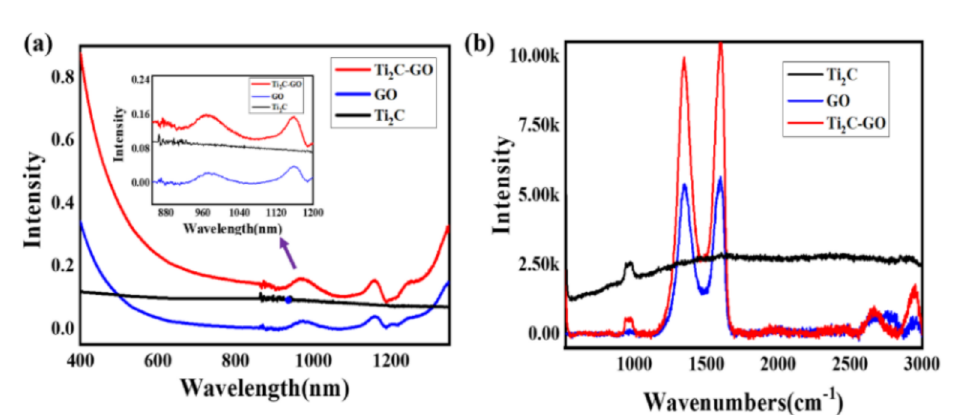
Figure 5. ( a ) Absorption spectra of the MXene–GO heterojunction, MXene material, and GO material; ( b ) Raman spectra of the MXene–GO heterojunction, MXene material, and GO